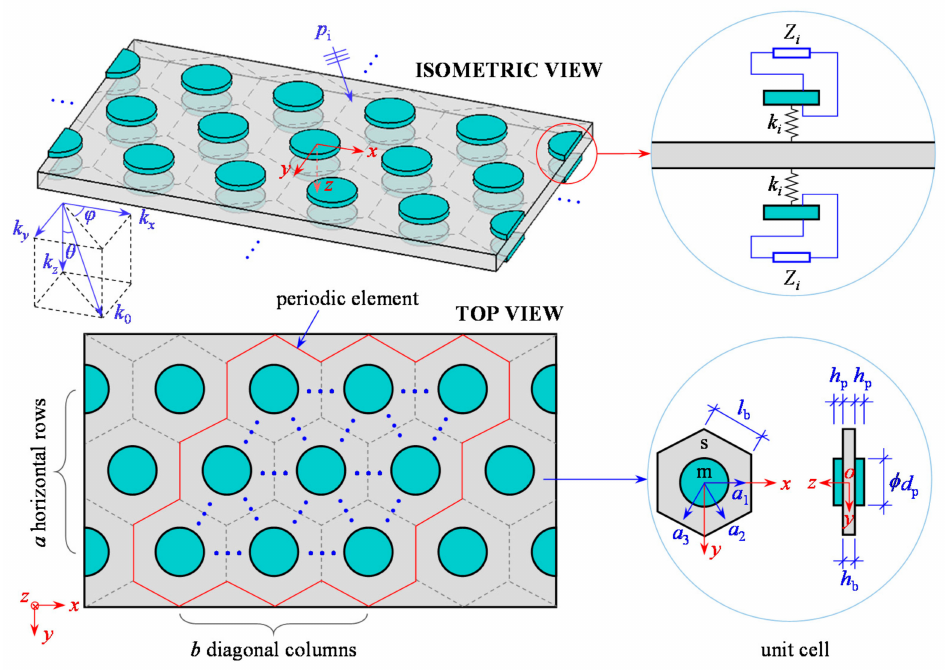
Figure 1. Schematic diagram of the metamaterial thin-plate containing subwavelength piezoelectric arrays with resonant